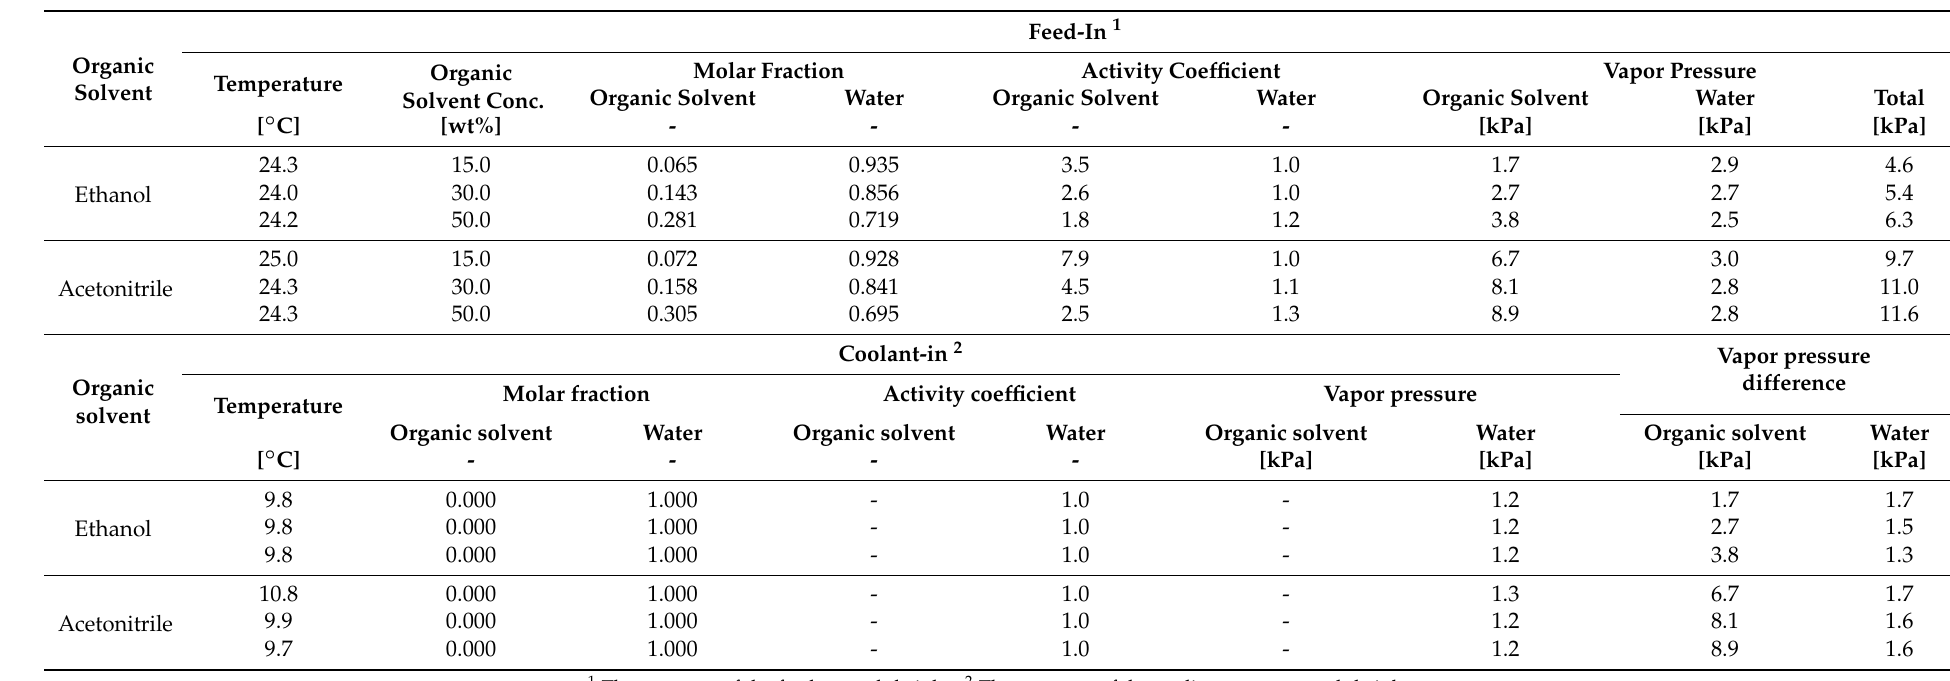
Table 8. The activity coefficient, vapor pressure of organic solvent and water, calculated from the operating conditions of feed-in temperature and mol-fraction.